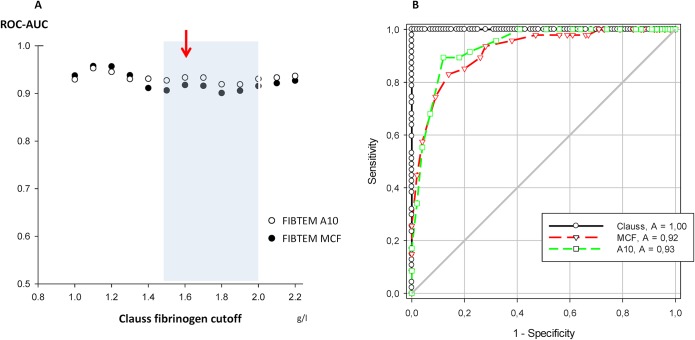
Discriminative power of FIBTEM variables for Clauss fibrinogen (A) and ROC curves at Clauss fibrinogen cutoff of 1.6 g/l (B).Red arrow = highest ROC-AUC in the recommended range for fibrinogen substitution by guidelines (blue transparent square). ROC, receiver operating characteristics.